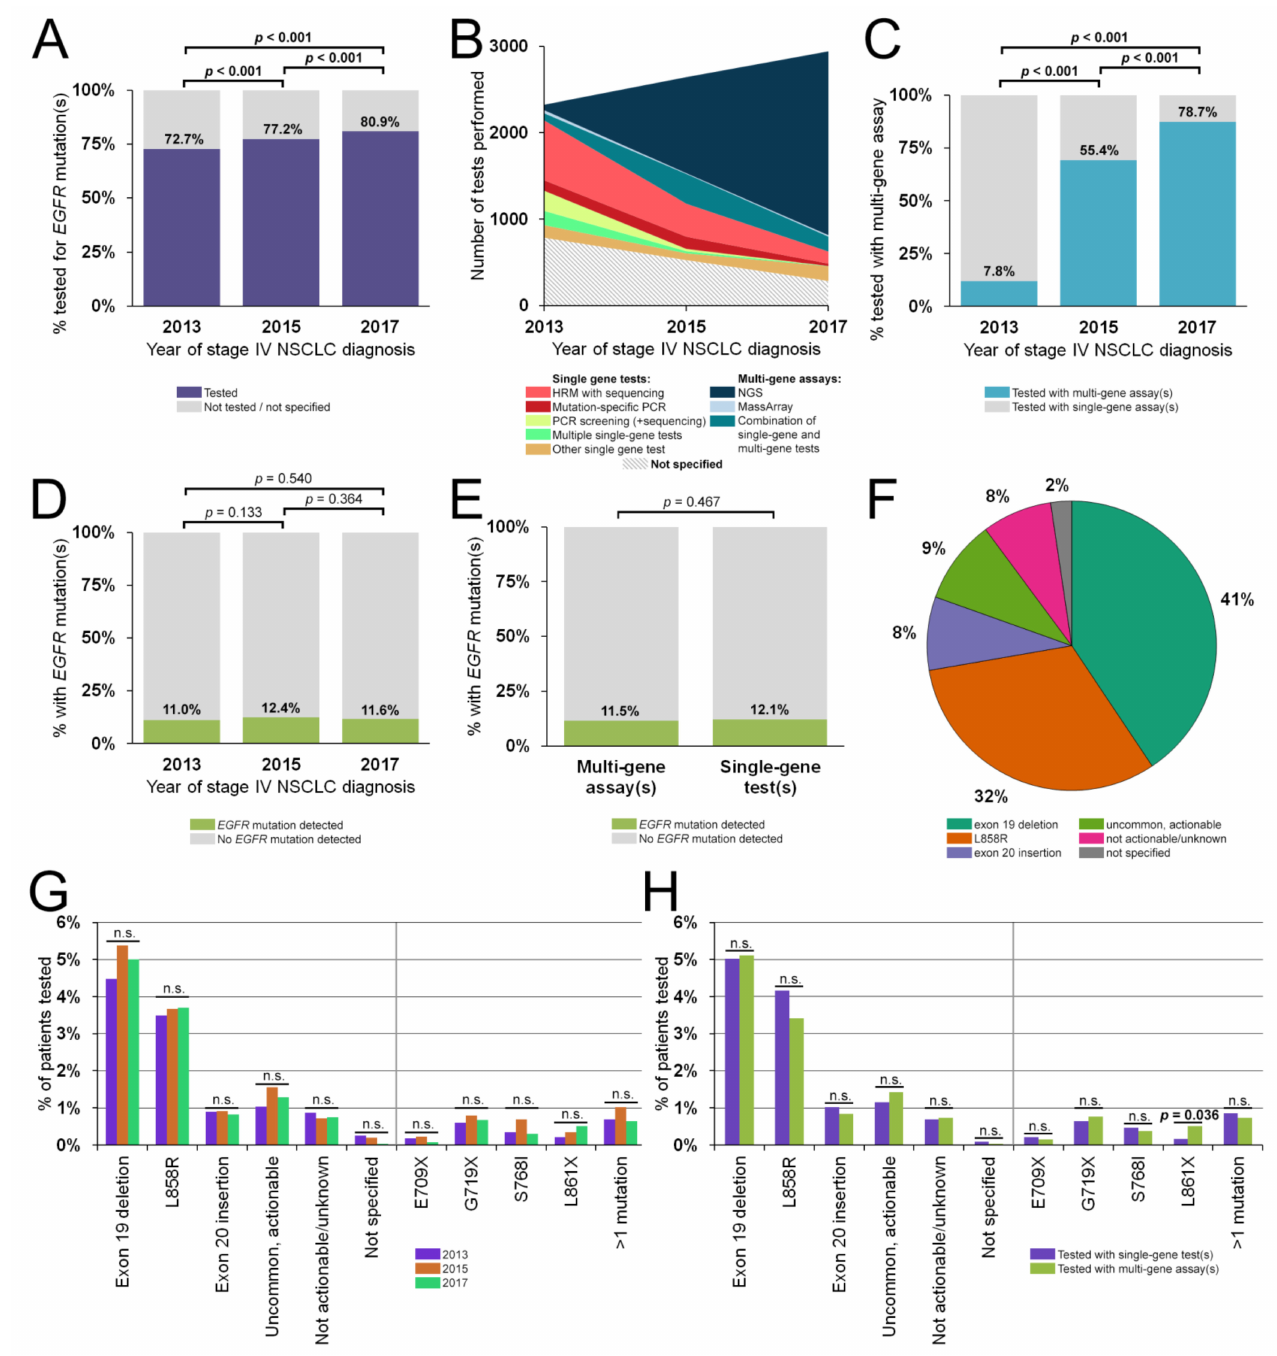
Figure 3. EGFR testing rates, methods and EGFR mutations. ( A ) Percentage of patients tested for EGFR mutations, by year of diagnosis. ( B ) Distribution of EGFR testing methods in number of tests by year. ( C ) Percentage of patients tested with single-gene versus multi-gene assays, by year of diagnosis. ( D , E ) Percentage of patients tested for EGFR mutations that tested positive for one or more EGFR mutation(s), by year of diagnosis ( D ) and multi-gene assay versus single-gene assay ( E ). ( F ) Distribution of EGFR mutation classes. ( G , H ) Comparison of distributions of EGFR mutation classes and occurrence of specific uncommon mutations, by year of diagnosis ( G ) and single-gene assay versus multi-gene assay ( H ). Abbreviations: EGFR , epidermal growth factor receptor gene; HRM, high-resolution melting; NGS, next-generation sequencing; n.s., not significant; NSCLC, non-small cell lung cancer; PCR, polymerase chain